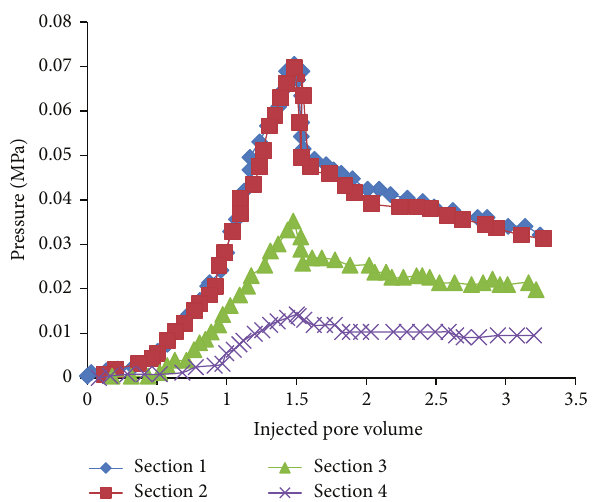
Figure 12: The plot of the injection pressure (diameter: 0.02– 0.06 mm, concentration: 1000mg/L).